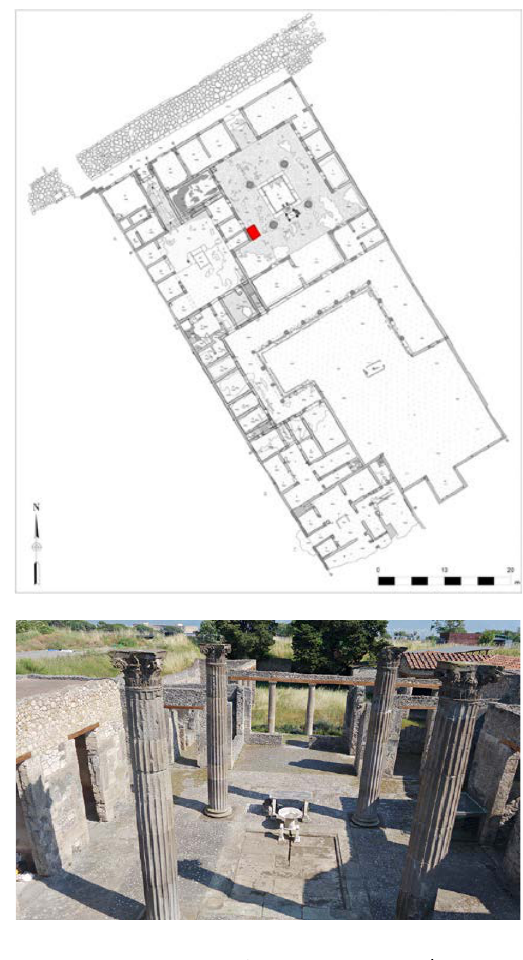
Figure 2. Top: Floor plan of the Obellio Firmo domus . In red the location of the safe, in the right side of the atrium tetrastylum (Campedelli et al., in press). Bottom: a view of the atrium (Silani et al., 2017).